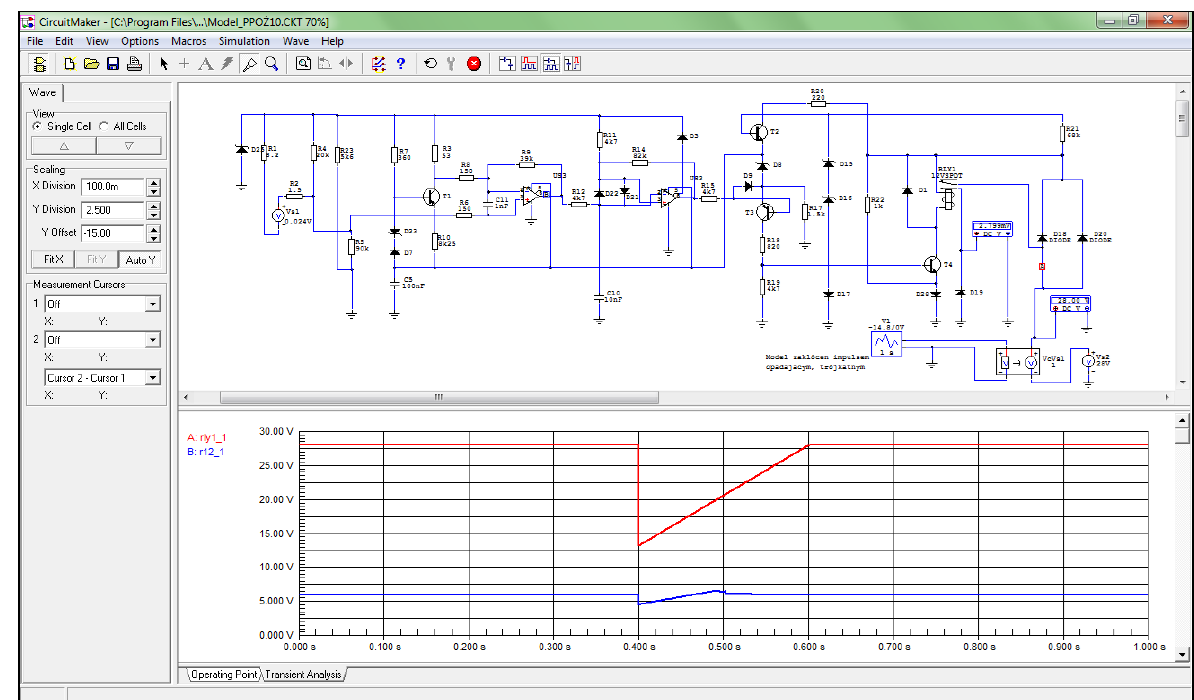
Figure 10. Voltage waveform at the output of signal comparator US1 (blue) for 24 mV.